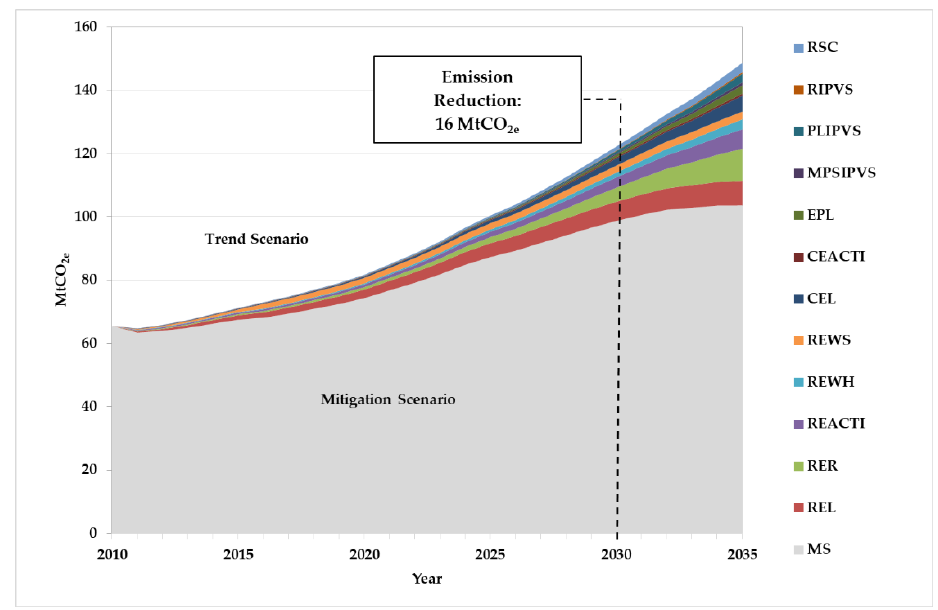
Figure 4. Avoided emissions by mitigation options in the RCPS sectors. Source: Own elaboration.